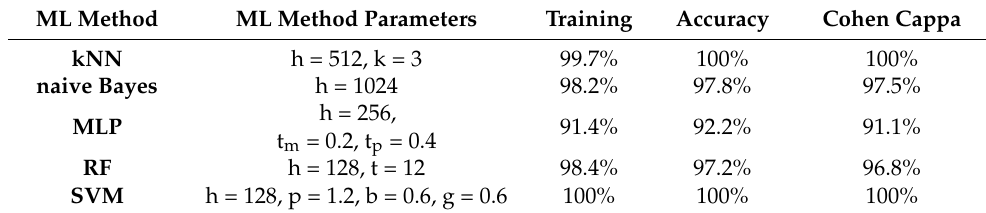
Table 4. Classification of PD classes using the proposed model.